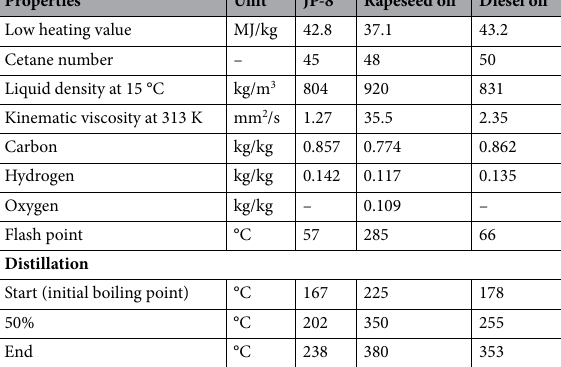
Table 1. The comparison of JP-8, rapeseed oil and diesel oil properties (Source: Authors, data from 33–35 ).